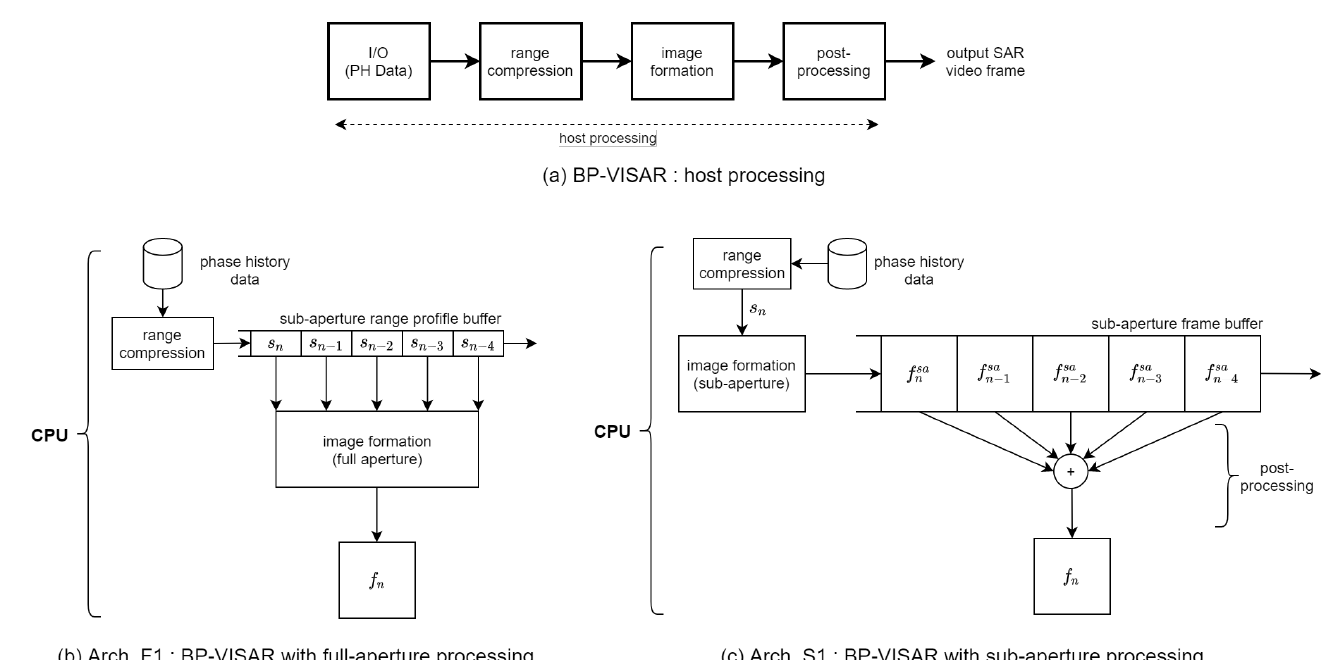
Figure 3. BP-VISAR baseline